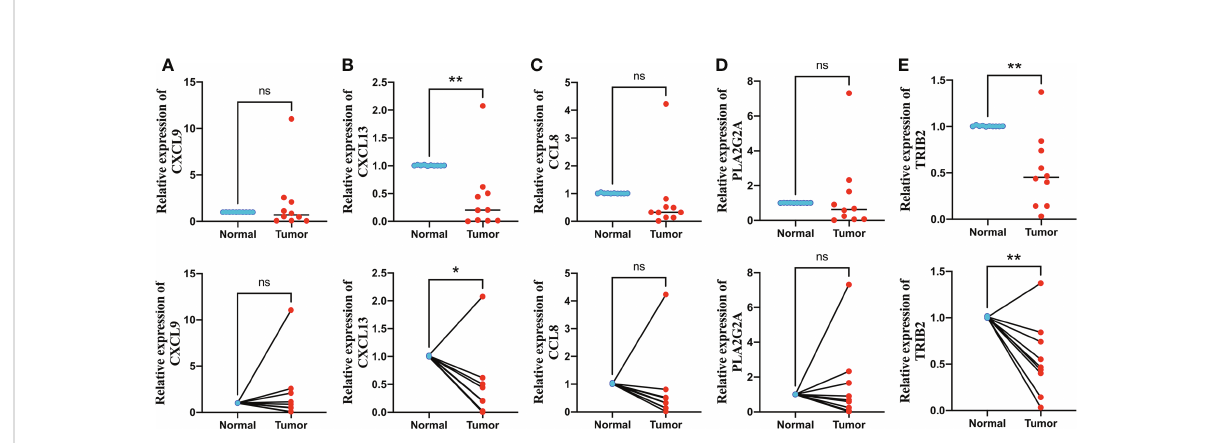
FIGURE 10 Quantitative real-time polymerase chain reaction (qRT-PCR) analyses of CXCL9 (A) , CXCL13 (B) , CCL8 (C) , PLA2G2A (D) and TRIB2 (E) expression in 10 pairs of CRC tissues and adjacent non-cancer tissues. * p < 0.05 and ** p < 0.01. ns p >